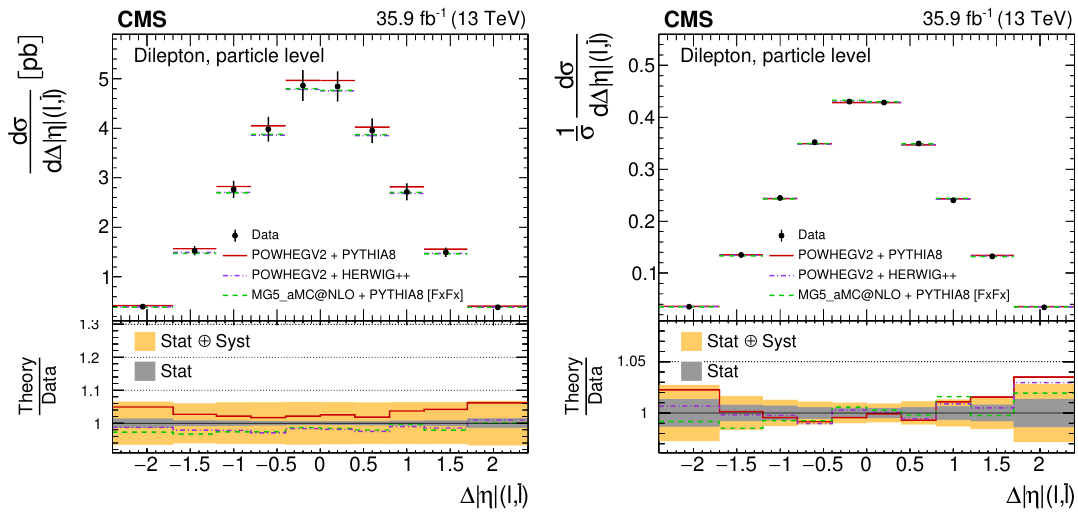
Figure 44 . The di(cid:11)erential tt production cross sections as a function of (cid:1) (cid:17) ( ‘; (cid:22) ‘ ) in a (cid:12)ducial phase space at the particle level are shown for the data (points) and the MC predictions (lines). The vertical lines on the points indicate the total uncertainty in the data. The left and right plots correspond to absolute and normalised measurements, respectively. The lower panel in each plot shows the ratios of the theoretical predictions to the data. The dark and light bands show the relative statistical and total uncertainties in the data, respectively.